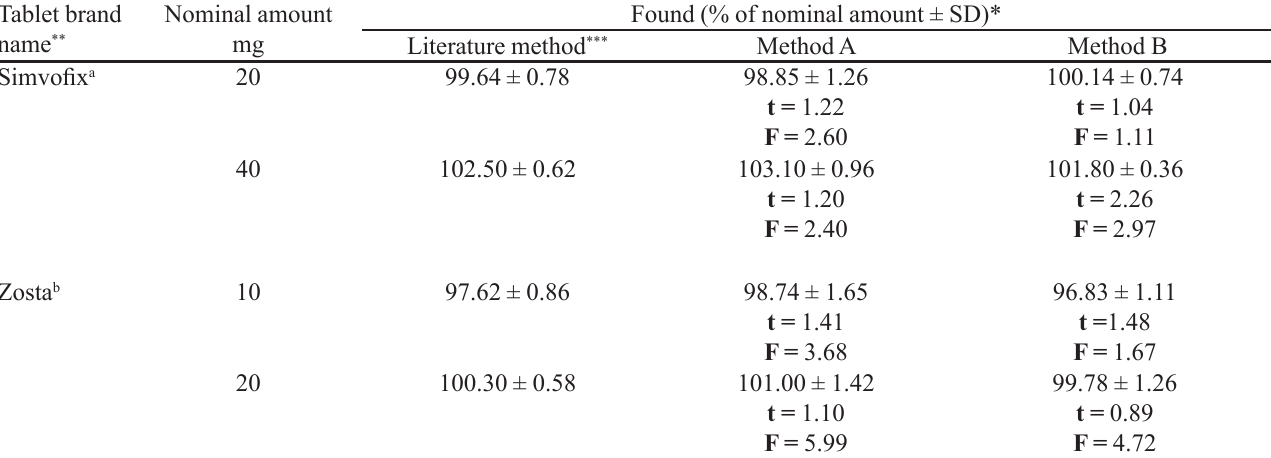
TABLE III - Results of assay of tablets and statistical evaluation Tablet